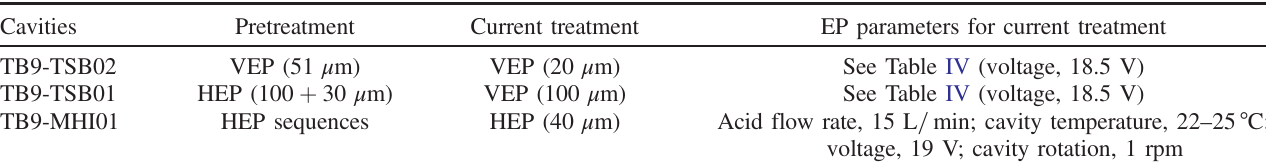
TABLE V. Details of the HEP and VEP treatments applied to three nine-cell cavities used for a comparison of removal trends and surface morphologies. Cavities Pretreatment Current